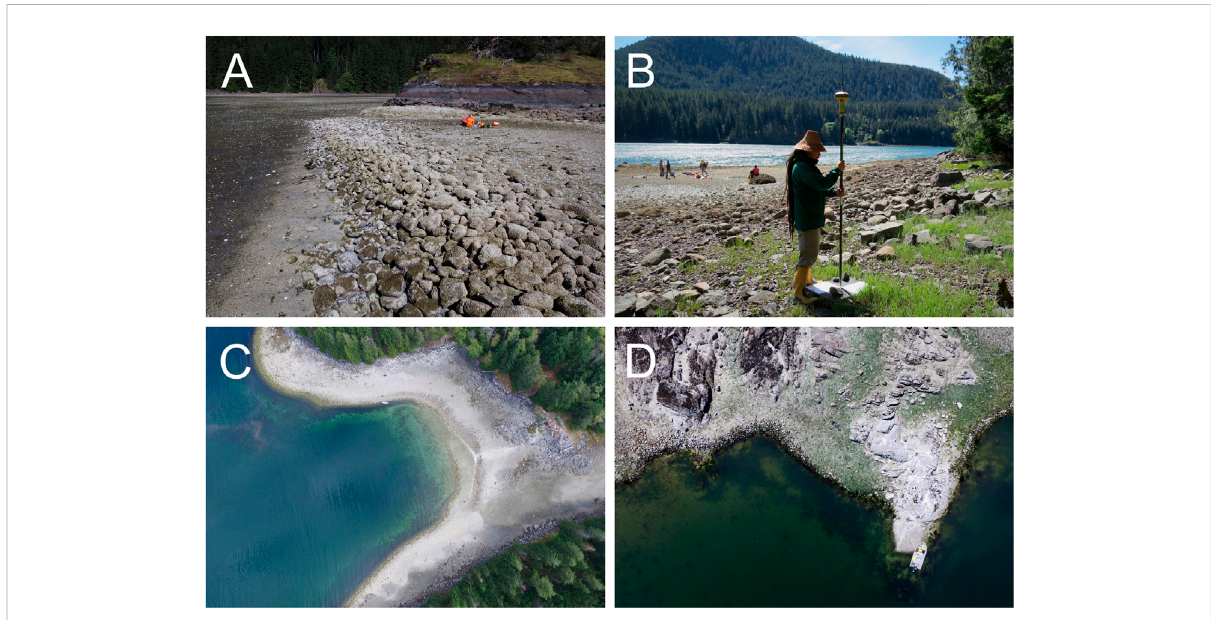
FIGURE 2 (A) Form one clam garden with terrace wall built on already existing clam habitat. (B) Real time kinematic survey prior to drone based imagery collection (C) Highlevel surveyview ofaclamgarden feature atsettlement andclam gardensiteEbSh-5inKanish Bay,showingentire shore